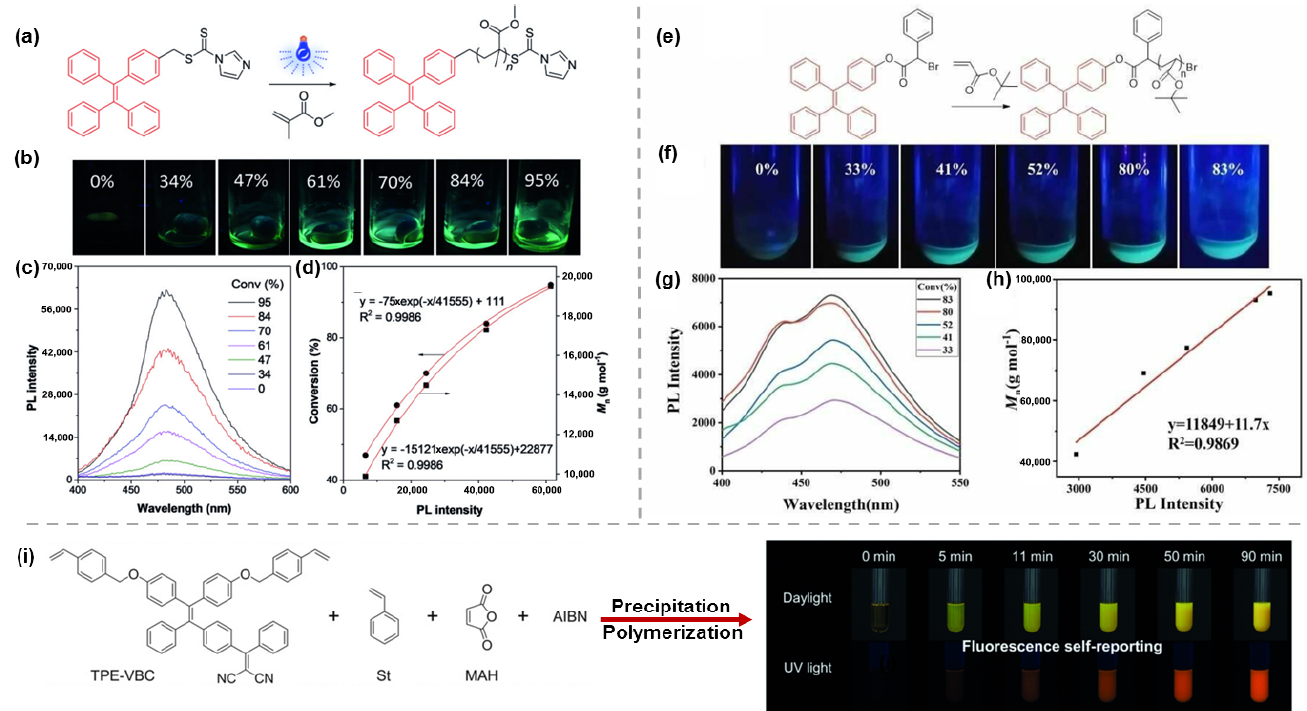
Figure 3. ( a ) Illustration of the RAFT reaction process. ( b ) The fluorescent photographs of the polymer solutions at different conversions taken under UV irradiation. ( c ) PL spectra of the polymerization mixtures at different conversions. ( d ) The exponential relationship of conversion and Mn with PL intensity. Reprinted with permission from Ref. [38]. 2018, Wiley-VCH. ( e ) Illustration of the ATRP reaction process. ( f ) Fluorescent photographs of the polymer solutions at different conversions taken under UV irradiation. ( g ) PL spectra of the polymerization mixtures at different conversion. ( h ) The linear relationship of Mn with PL intensity. Reprinted with permission from Ref. [40]. 2020, Wiley-VCH. ( i ) Illustration of the precipitation polymerization process and fluorescent photographs of the mixtures monitored under daylight and UV light at different times. Reprinted with permission from Ref. [41]. 2019, Wiley-VCH.